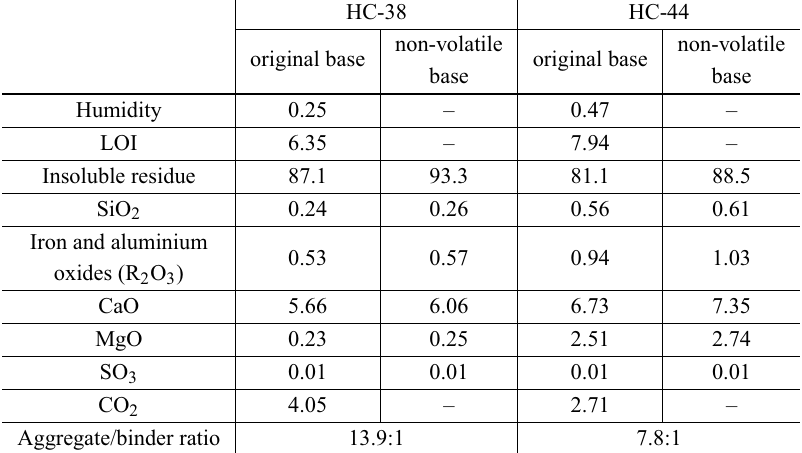
Estimate of aggregate/binder ratio and chemical composition of the mortar in wt%. HC-38 HC-44 non-volatile original original base